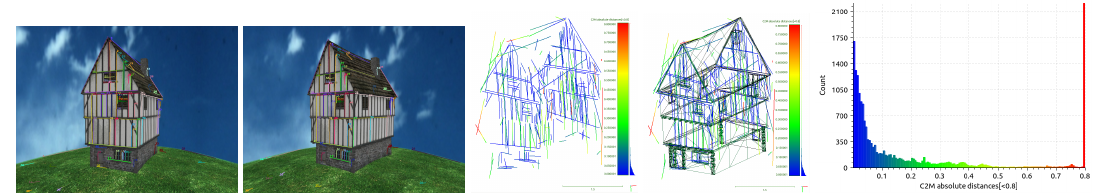
Figure 1. Resulting line matching using the proposed method for images {5,8} of the dataset [11]. Resulting 3D abstraction and measurements of distances to Ground Truth mesh.